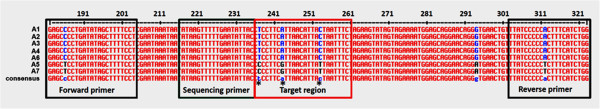
Alignment of the cytochrome c oxidase subunit I (COI) gene derived from seven samples. Position of the forward primer (Anop_COI_F) and biotinylated reverse primer (Anop_COI_Rb) for template amplification are shown in the black boxes, while the sequencing primer (Anop_COI_S) and target region are shown in the green and red boxes, respectively. Asterisks indicate position of the target region used for species level identification.